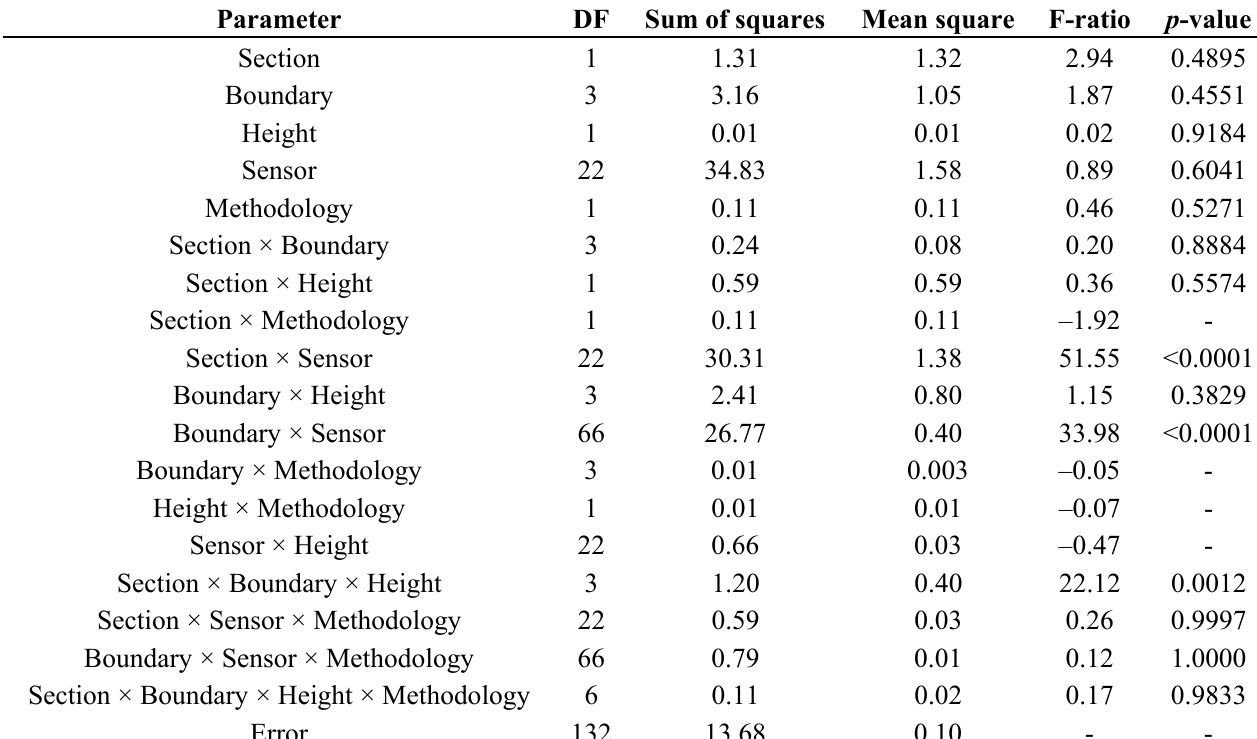
Table 4. ANOVA of air velocity at different